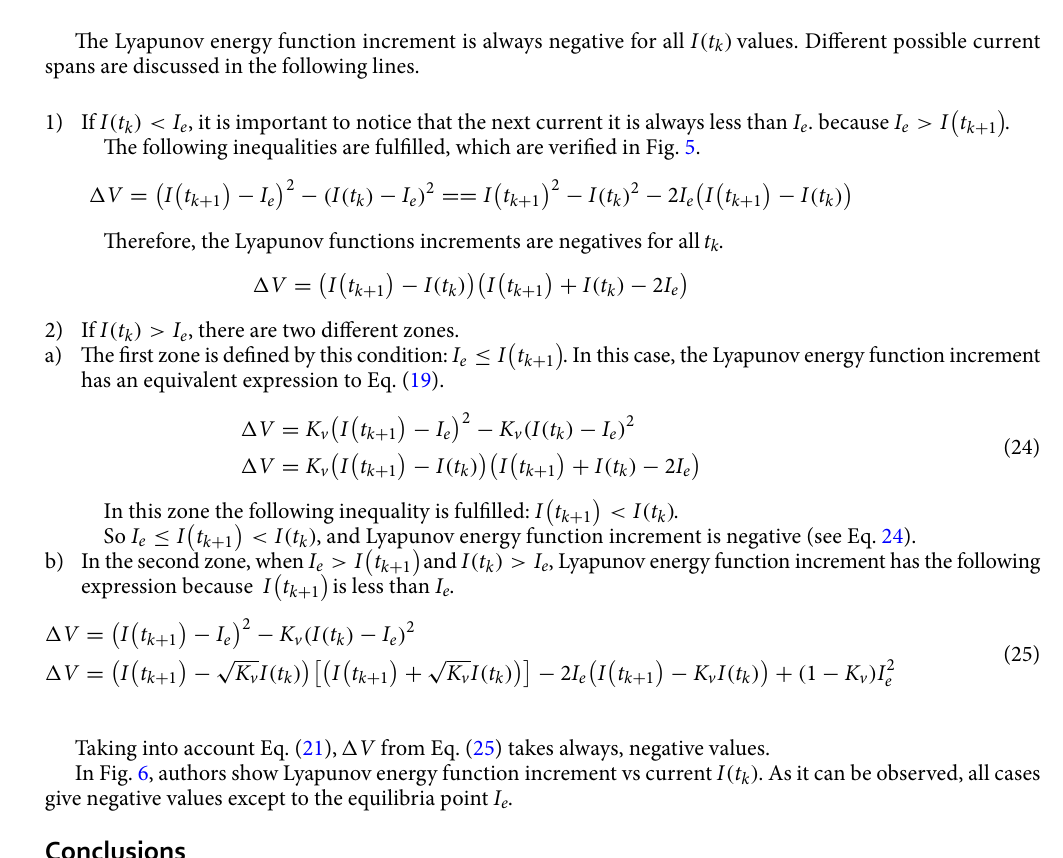
Figure 6. Lyapunov energy increments vs I ( t k ) for 1000 W/m 2 irradiance and 20 °C